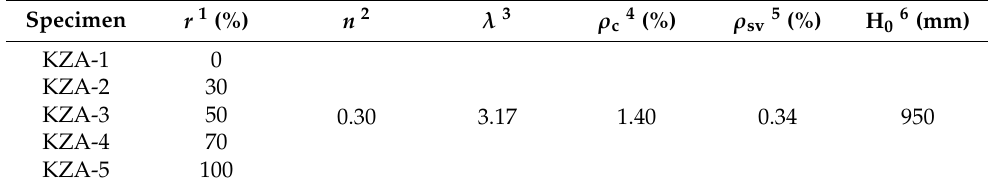
Table 4. Specimen